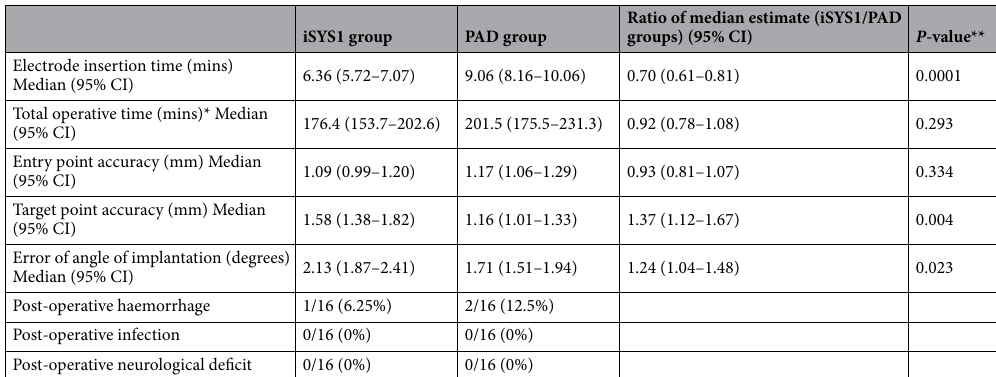
Table 3. Post-operative median estimates by group and between-group median ratio estimates (with 95% confidence intervals) from log-linear models fitted to the outcomes, assuming a log-normal distribution for outcome data. Summary of post-operative outcomes by treatment group. *Difference estimate adjusted by number of electrodes inserted. For electrode-level data, n = 160 for the iSYS1 group and n = 168 for the PAD group (with the exception of entry point accuracy, target point accuracy and angle error in the iSYS1 group where n = 159). ** P -values for a t-test of the null hypothesis of no difference in the corresponding outcome between groups, performed using log-transformed outcomes when fitting log-linear